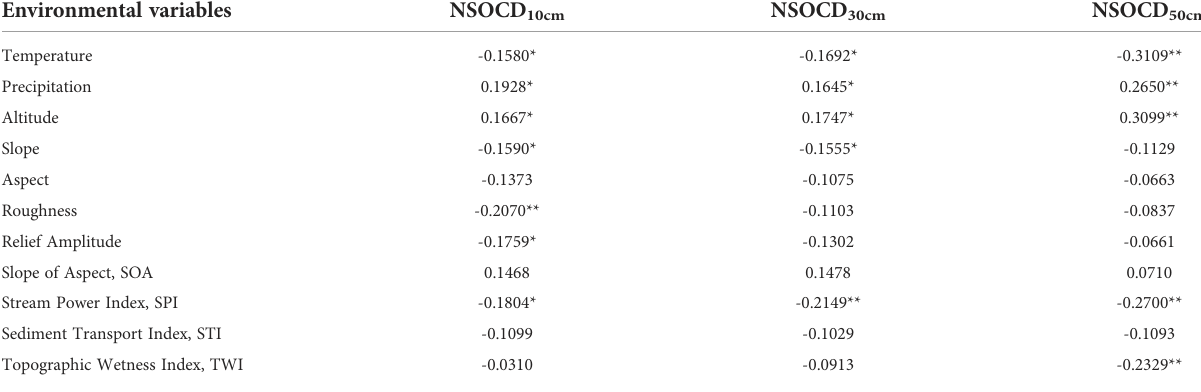
TABLE 2 The correlation between the soil organic carbon density and the environmental variables in different soil